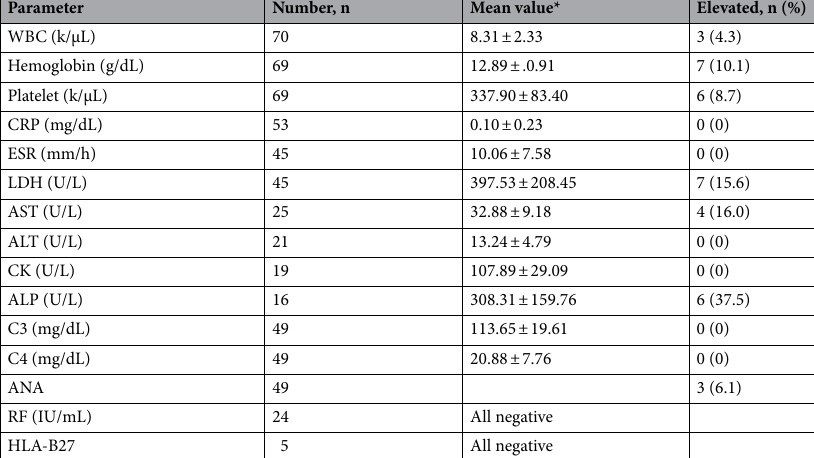
Table 2. Laboratory features in patients with growing pains. WBC white blood count, CRP C-reactive protein, ESR erythrocyte sedimentation rate, LDH lactate dehydrogenase, AST aspartate aminotransferase, ALT alanine aminotransferase, CK creatine kinase, ALP alkaline phosphatase, C3 Complement 3, C4 Complement 4, ANA antinuclear antibodies, RF rheumatoid factor, HLA-B27 human leukocyte antigen B27. The values are expressed as mean ± standard